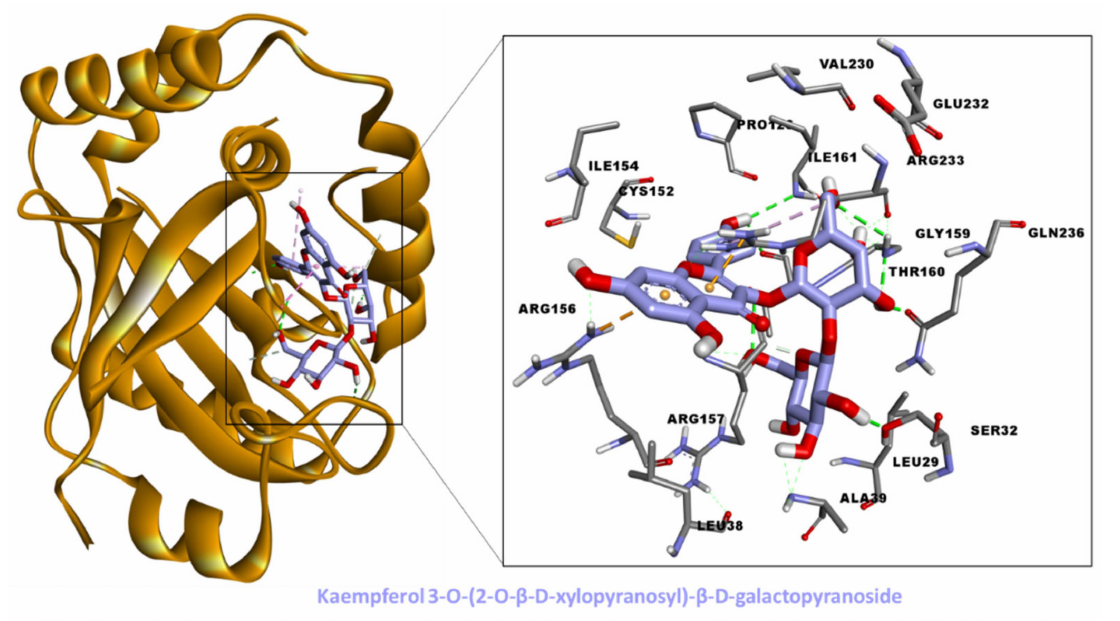
Figure 8. Interaction between HSV-1 protease and kaempferol 3- O -(2- O - β - D -xylopyranosyl)- β - D - galactopyranoside.